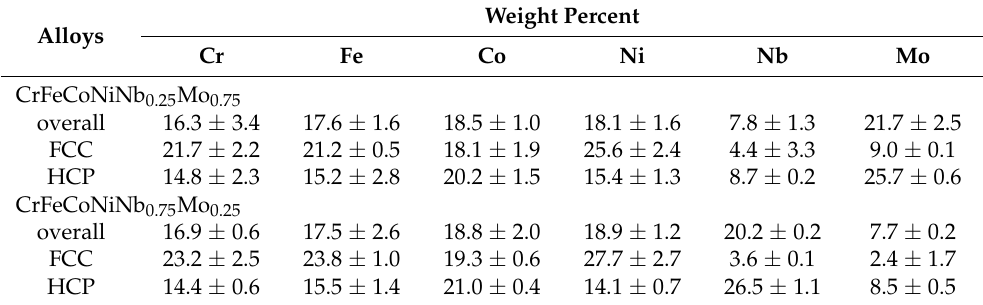
Table 6. The chemical compositions of the as-cast CrFeCoNiNb x Mo 1 − x alloys and the phases in each alloy analyzed by